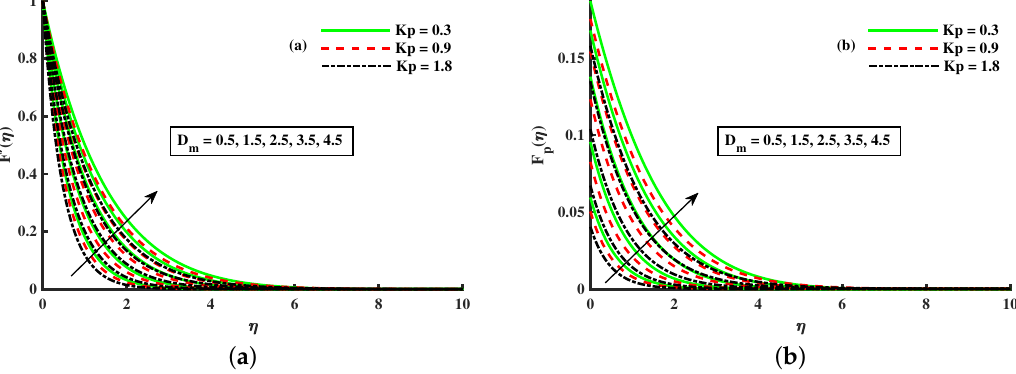
Figure 8. Fluctuation of Kp and D m on F (cid:48) ( η ) ( a ) and the effect of Kp and D m on F p ( η ) ( b